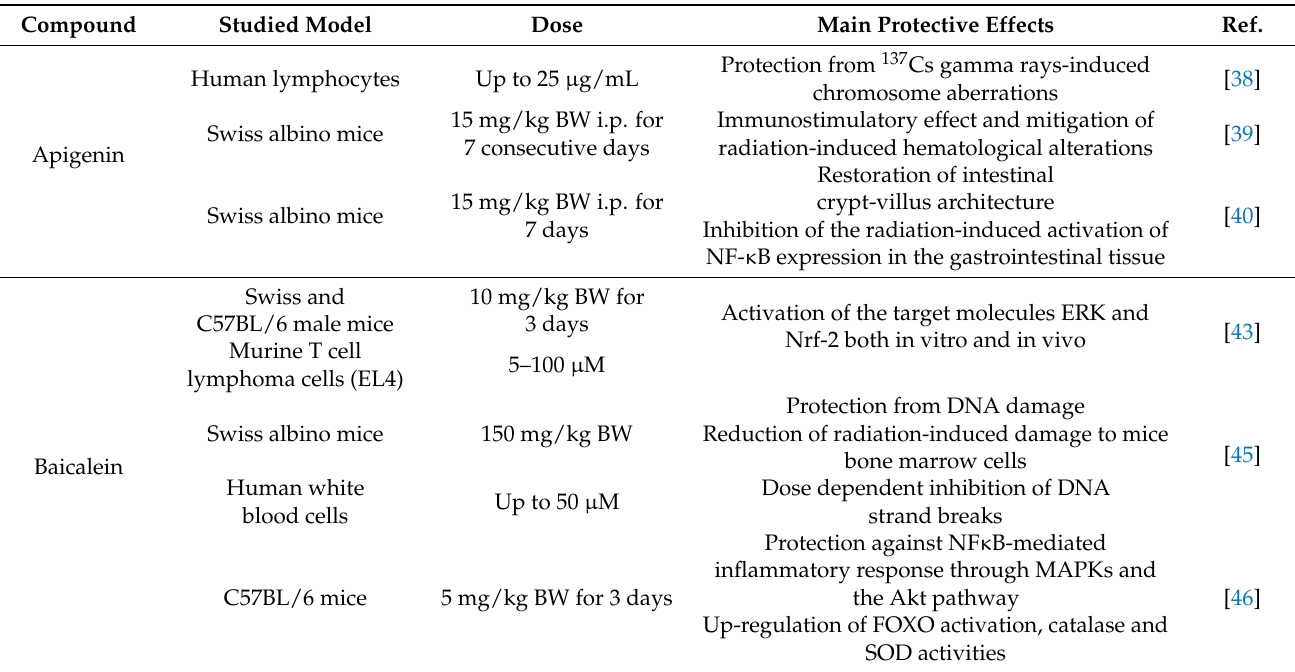
Radioprotective properties of natural phenols and polyphenols herein described (BW = body weight; i.p. = intraperitonially; s.c. = single subcutaneous; i.m. = intramuscular; i.g. =